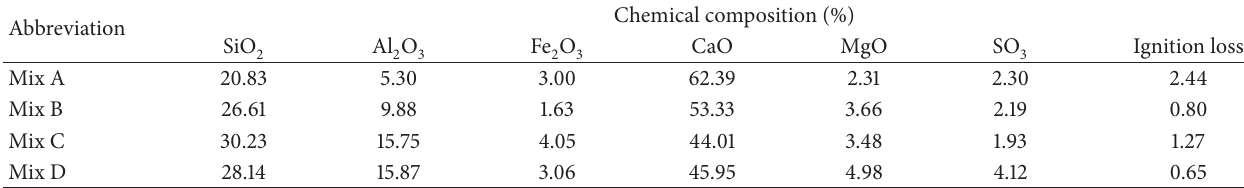
Table 3: Chemical composition of premixed binders.